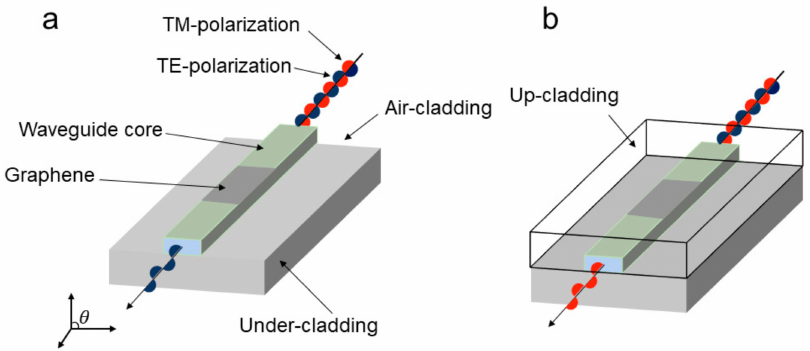
Figure 3. Schematic of a polymer-based planar-lightwave-circuit (PLC)-type graphene polarizer. ( a ) The polarizer serves as a TE-pass polarizer because the graphene strip with the air cladding supports TE mode surface wave. ( b ) Due to the fact that the waveguide is covered with a UV-curable polymer resin, the electrical properties of the graphene strip are adjusted to support the TM-mode surface wave. Thus, the waveguide serves as a TM-pass